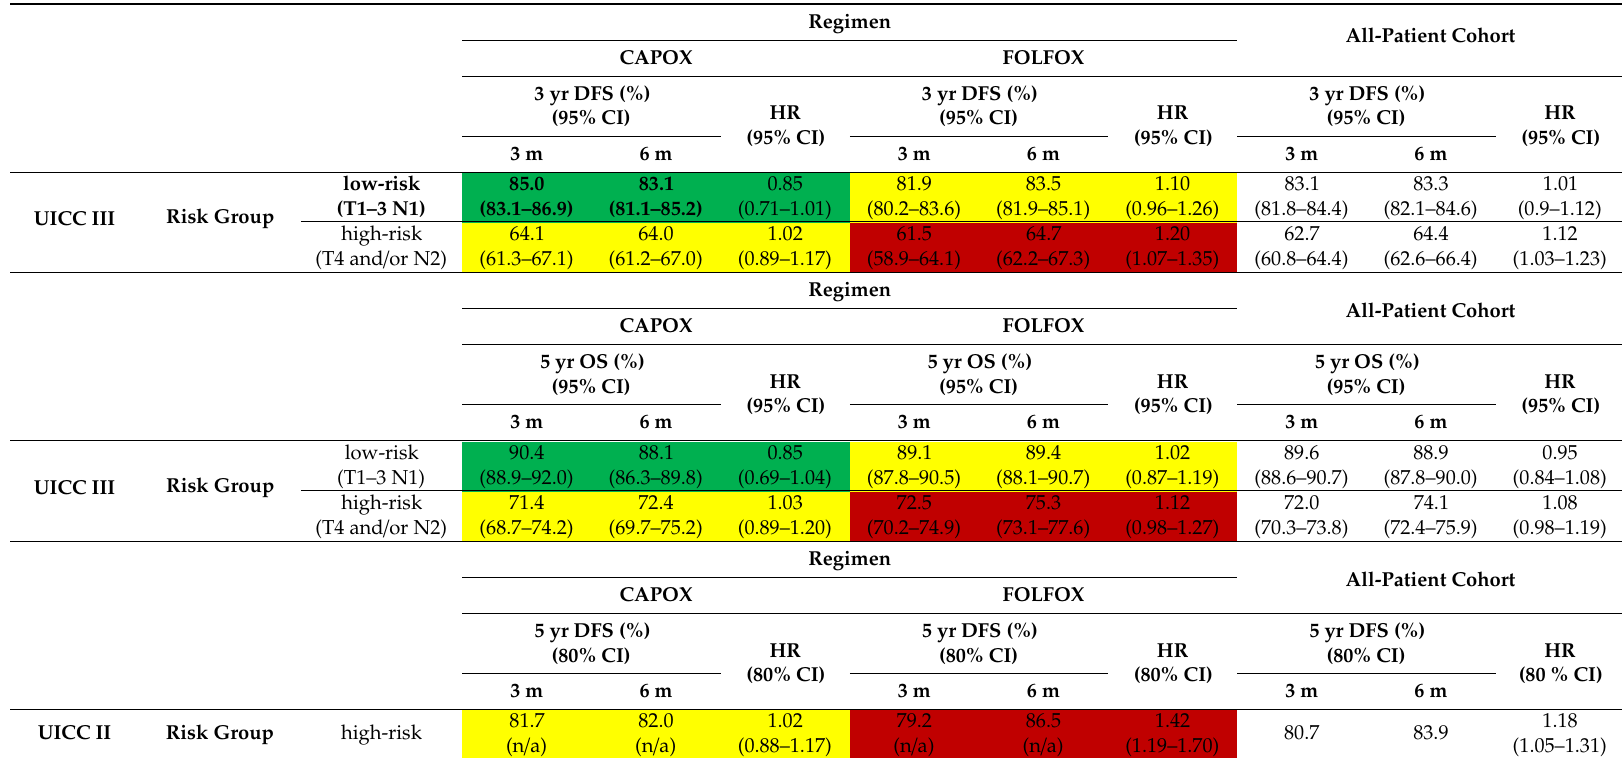
Table 1. yr DFS rate by risk group and regimen (modified by Grothey et al. [18] and Iveson et al.